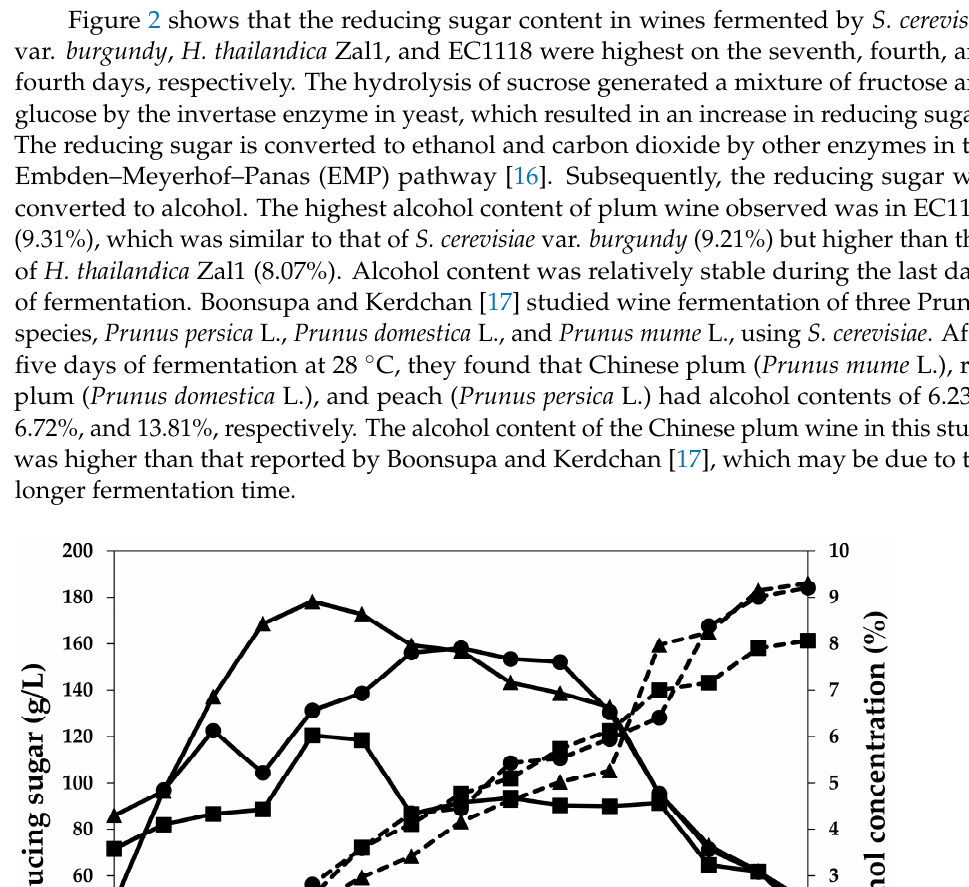
Figure 3. Change in yeast population during plum wine fermentation using S. cerevisiae var. bur- gundy (  ), H. thailandica Zal1 (  ), and EC1118 (  ). 2.3. Total Phenolic Content and Antioxidant Activity Generally, TP analysis measures the reduction capacity of the sample in a similar way to antioxidant activity analysis. Several studies reported a linear relationship between TP and antioxidant activity [19]. Similarly, the TP content of plum wine fermented by S. cere- visiae var. burgundy and commercial yeast EC118 increased from the first to last day, which is similar to the trend of antioxidant activity. The highest phenolic content was determined by the Folin–Ciocalteu reagent, and total antioxidant activities were determined by DPPH of plum wine fermented by S. cerevisiae var. burgundy were 469.84 ± 6.95 mg/L of gallic acid equivalents (GAE) and 304.36 ± 6.24 µg/L of Trolox equivalents (TE), respectively (Table 1), which was significantly different with plum wine fermented by H. thailandica Zal1 and EC1118. The TP content and antioxidant activity of plum wine fermented by H. thailandica Zal1 decreased slightly from the first to the last day. This result was in agree- ment with the study of Towantakavanit et al. [20], which reported that the decrease in the TP level could have been due to modification of the phenolic composition by processes such as oxidation, condensation, and polymerization. The obtained results were con- sistent with those of these studies. The TP contents of Chinese plum, red plum, and peach